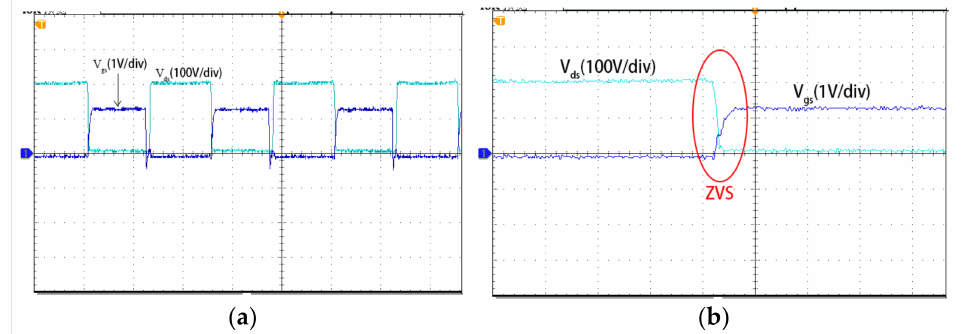
Figure 9. Experimental results for f s = 100 kHz: ( a ) Steady-state waveforms (time scale: 4 µ s/div); ( b ) Soft-switching waveforms (time scale: 800